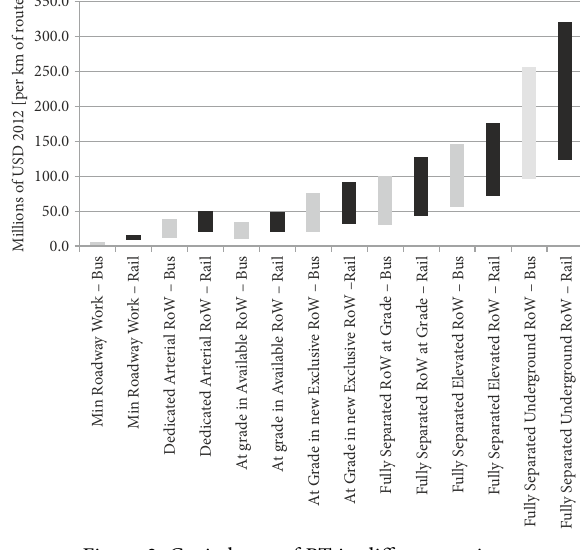
Figure 2. Capital cost of PT in different settings